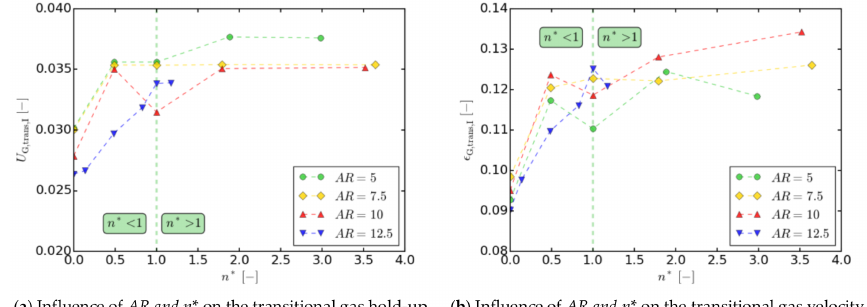
Figure 10. Influence of AR and n * on flow regime transition points—Data obtained from ref. [28].